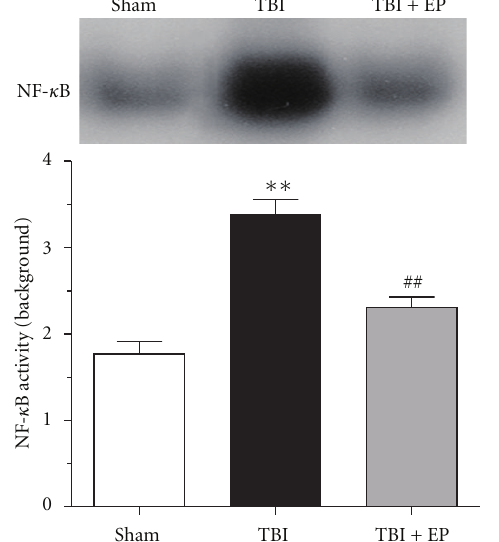
Figure 6: NF- κ B DNA binding activity in the brain tissue surroun- ding the contusion cortex in Sham group, TBI group, and TBI + EP group. Upper panel: EMSA autoradiography of NF- κ B DNA binding activity. Lower panel: quantification of NF- κ B DNA binding activity was performed by densitometric analysis. As compared with Sham group, NF- κ B binding activity measured by EMSA was significantly increased after TBI. However, compared to TBI group, EP treatment significantly suppressed NF- κ B binding activation in TBI + EP group. Bars represent as mean ± SEM; n = 6, each group; ∗∗ P < . 01 versus Sham group, P < . 01 versus TBI group.